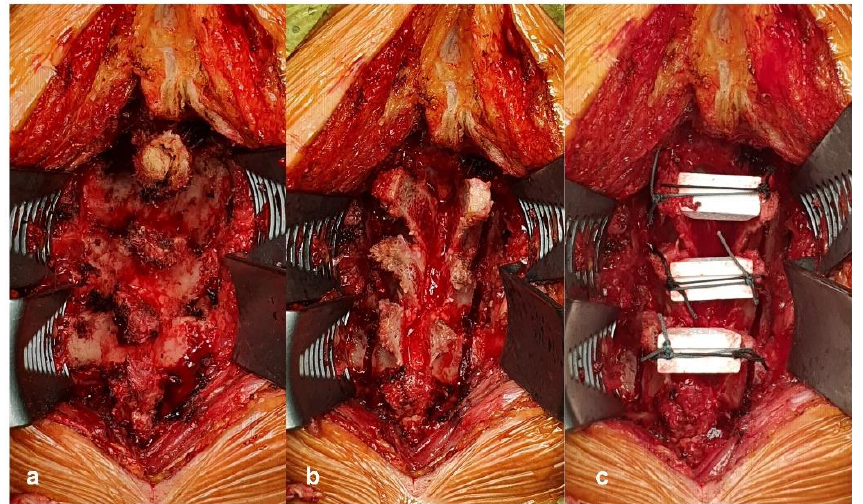
Figure 2. Surgical procedure technique in this study. ( a ) Cervical laminae are exposed laterally to the medial aspect of the facet joints. ( b ) The spinous processes are split sagittally, and bilateral gutters for the hinges are made. ( c ) The split laminae is opened bilaterally, and a hydroxyapatite spacer is placed inside.